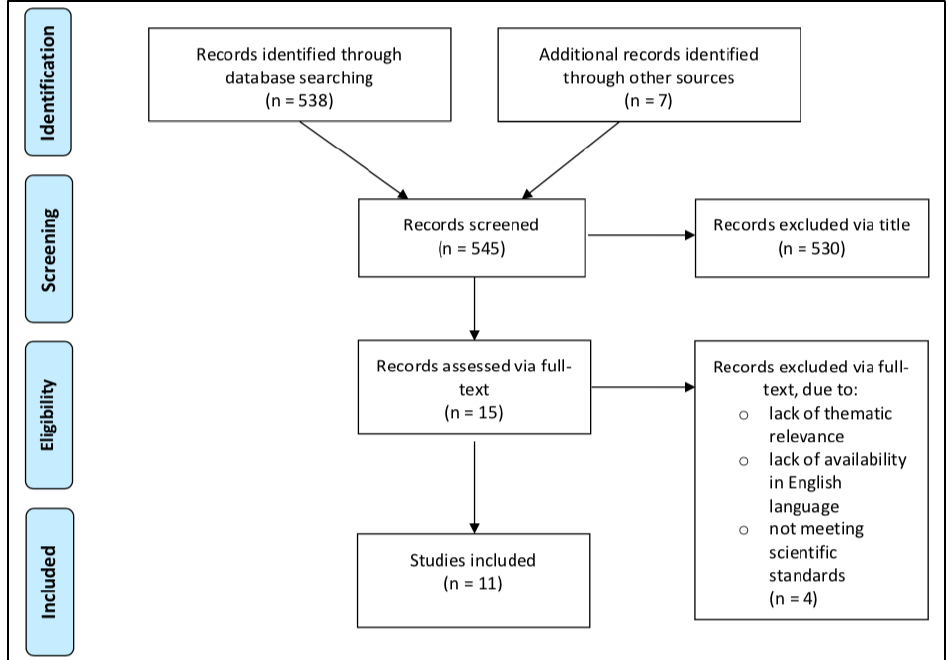
Figure 1. Prisma flow diagram [22].